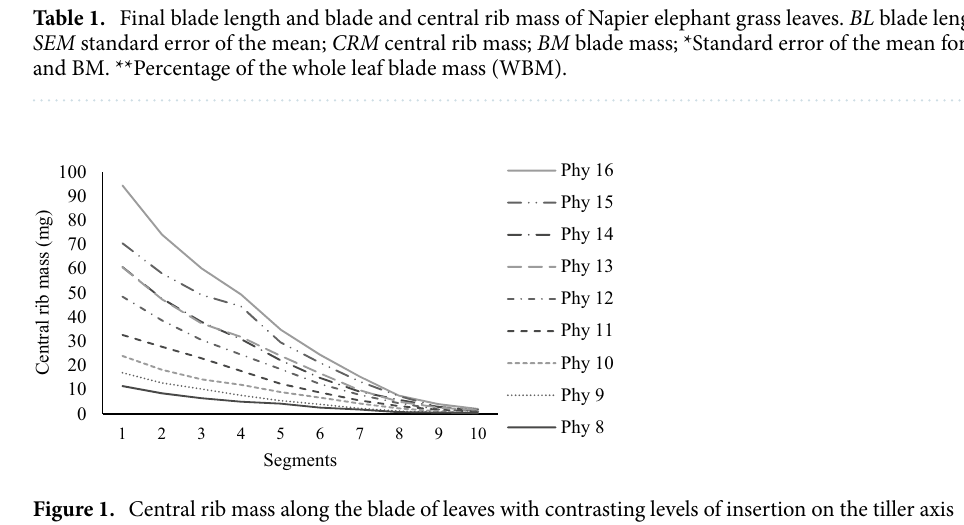
Figure 1. Central rib mass along the blade of leaves with contrasting levels of insertion on the tiller axis (phytomers) of Napier elephant